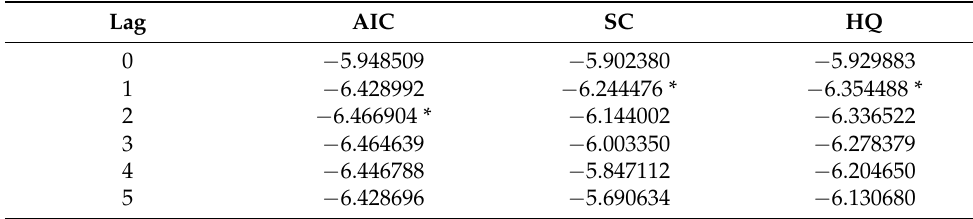
Table 3. Determination of lag